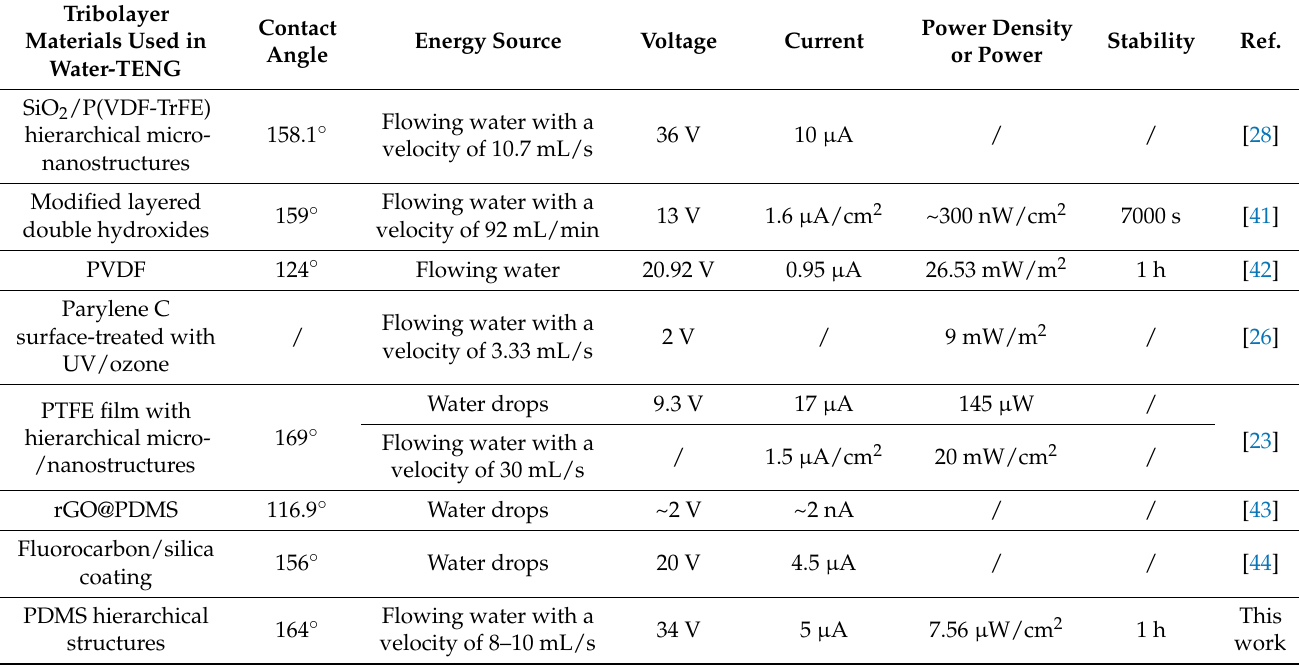
Table 1. Comparison of many water-TENGs in terms of materials used, contact angle, and output